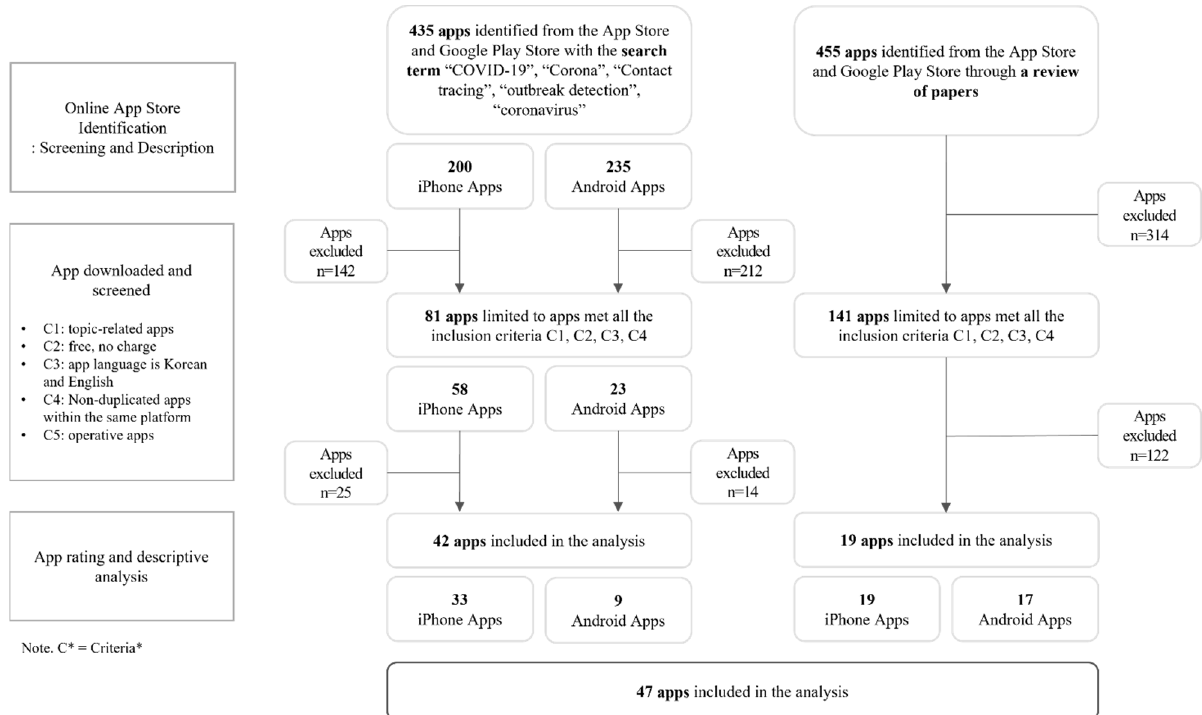
Figure 2. Flowchart of COVID-19 mobile identification; screening and review of COVID-19 mobile apps.